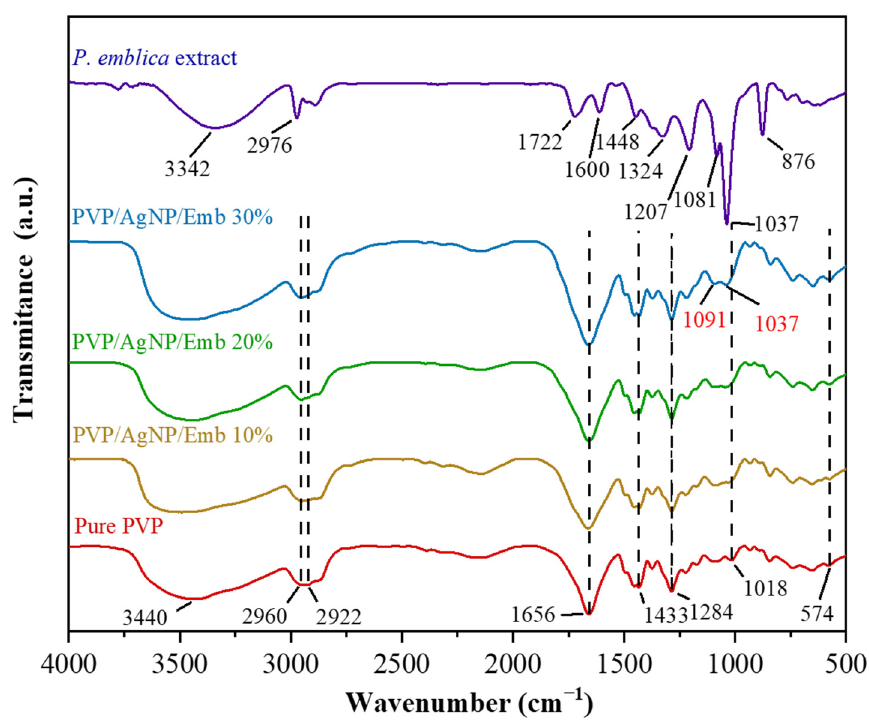
Figure 5. FTIR spectra of Phyllanthus emblica extract, composite spray-on dressing films loaded with different amounts of Phyllanthus emblica extract, and pure PVP film.